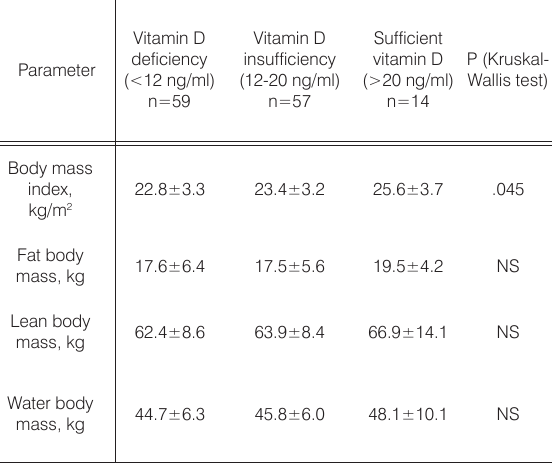
Table 3 Body composition in different subgroups by vitamin D concentration in all participants